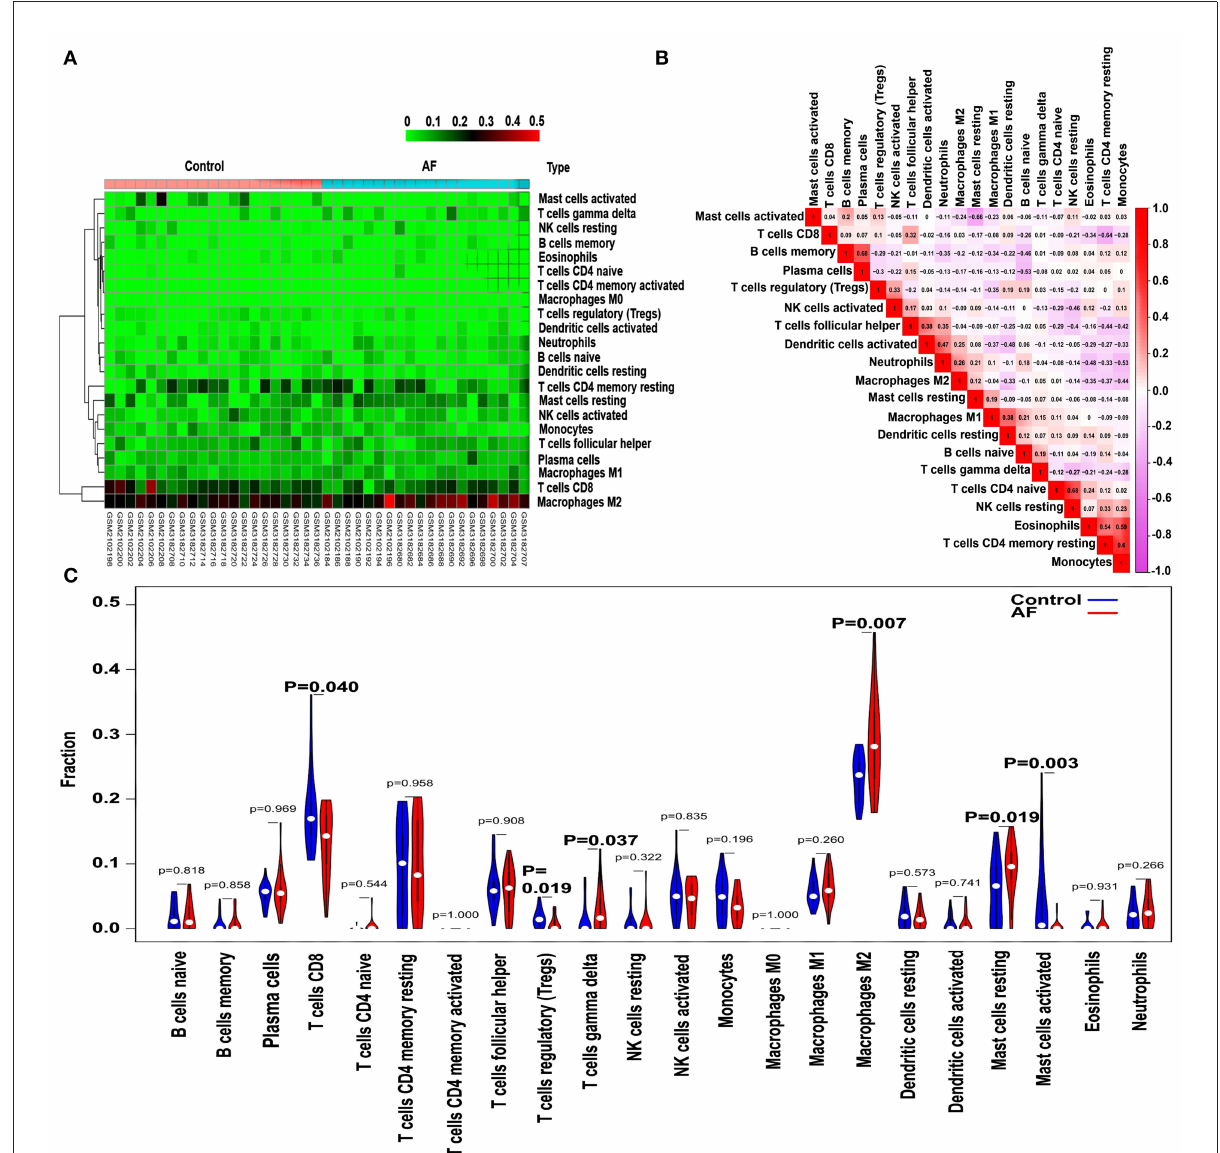
FIGURE5 Pattern of immune cell subtype infiltration in the training set. (A) Representative heatmap representing the proportions of different immune cells. (B) Representative heatmap showing the correlations of the indicated immune cells. (C) Representative violin plot showing the different fractions of infiltrated immune